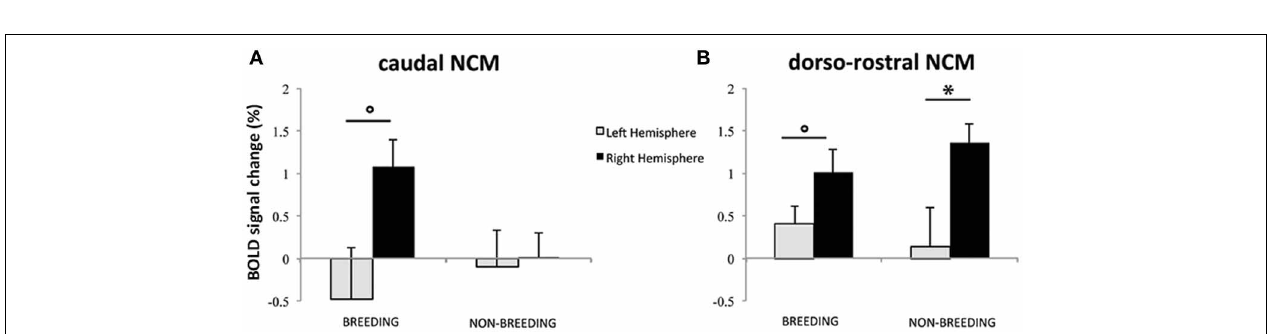
FIGURE 6 | Lateralization of differential song processing. (A) Estimates of the relative amplitude of differential song responses in left and right caudal NCM. (B) Estimates of the relative amplitude of differential song responses in left and right dorso-rostral NCM. Positive values indicate that the region was more activated by INDIV than by SPEC. Negative values